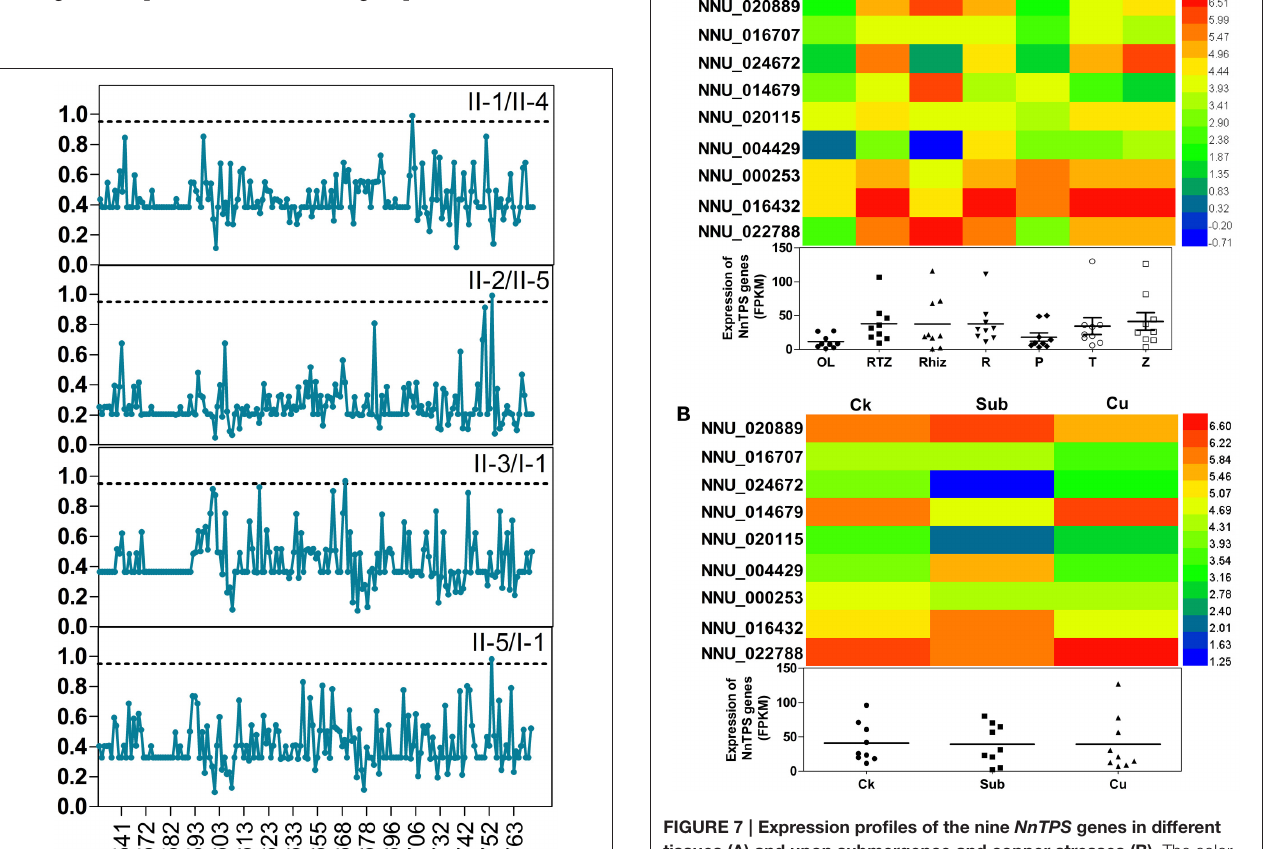
Frontiers in Plant Science |